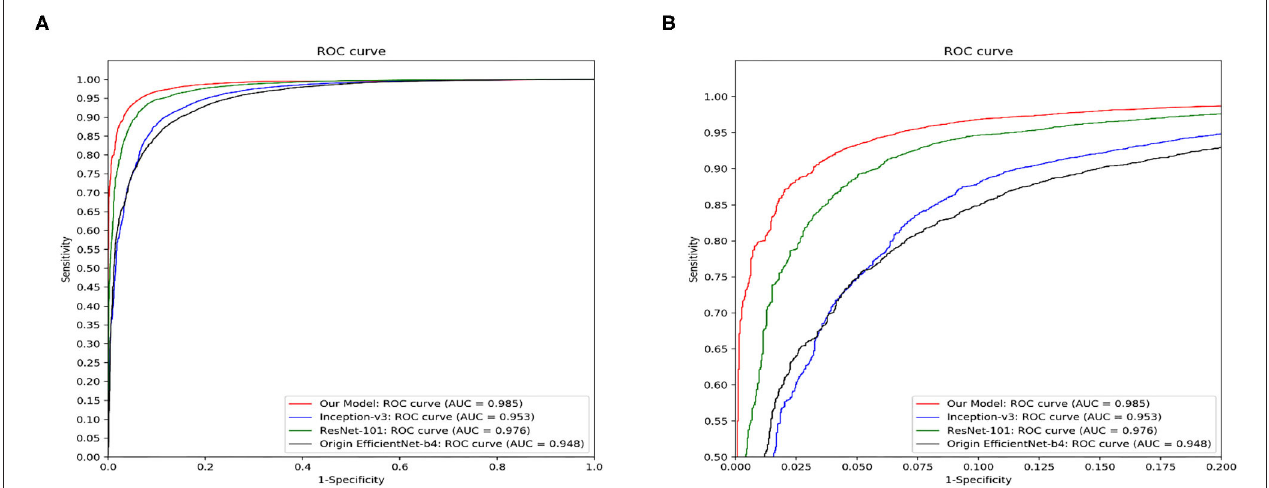
FIGURE 7 | The ROC curves and the AUC value of our model, Inception-v3, ResNet-101 and the original EfficientNet-b4. Our model outperforms other reported methods for this skin disease diagnosis problem. (A) The full view of the ROC curve of the proposed model. (B) The local enlarged image of the ROC curve between abscissa 0 ∼ 0.2.